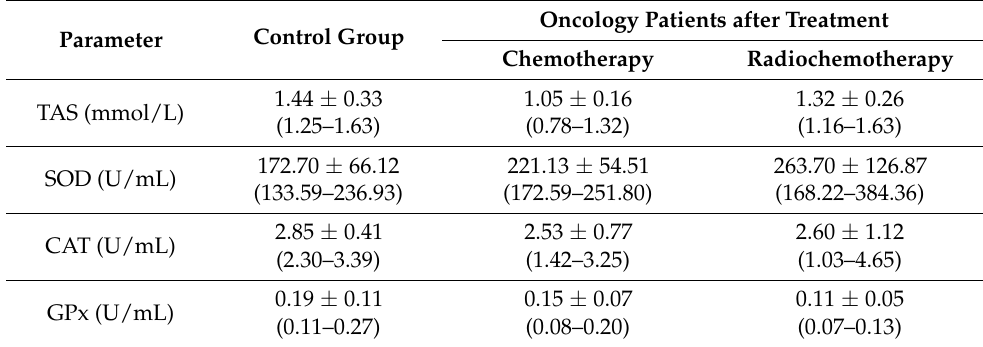
Table 5. Activity levels of blood antioxidants of oncology patients and the control